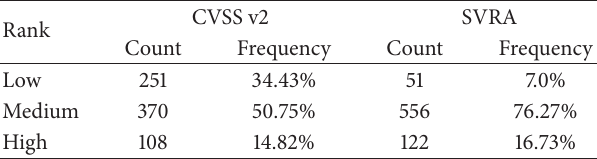
Figure 11: Experimental SVRA scores (a) and CVSS v2 scores (b), where 𝑇 = {2002, 2003, . . .} and 𝑡 = 2012 . Table 8: NVD severity rankings for theoretical